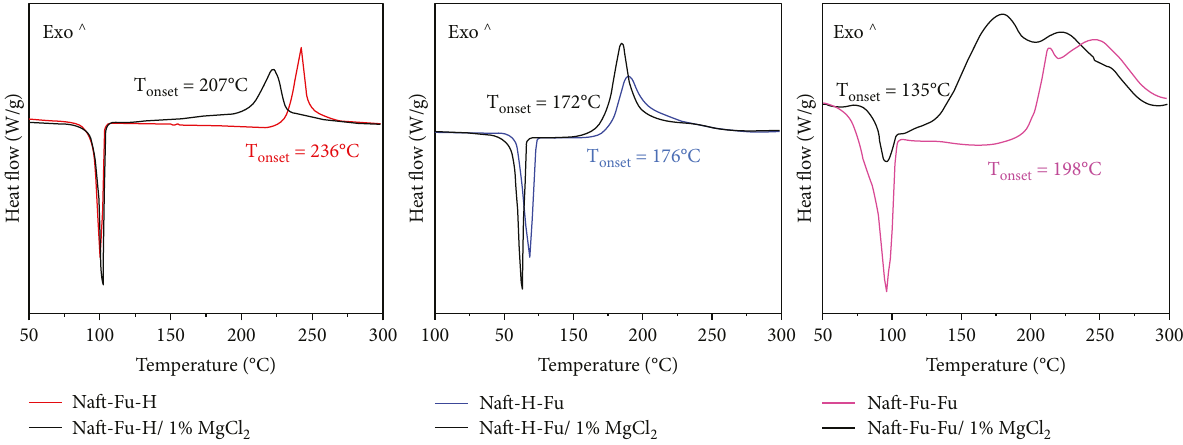
Figure 11: DSC curves of naphthoxazines with and without MgCl